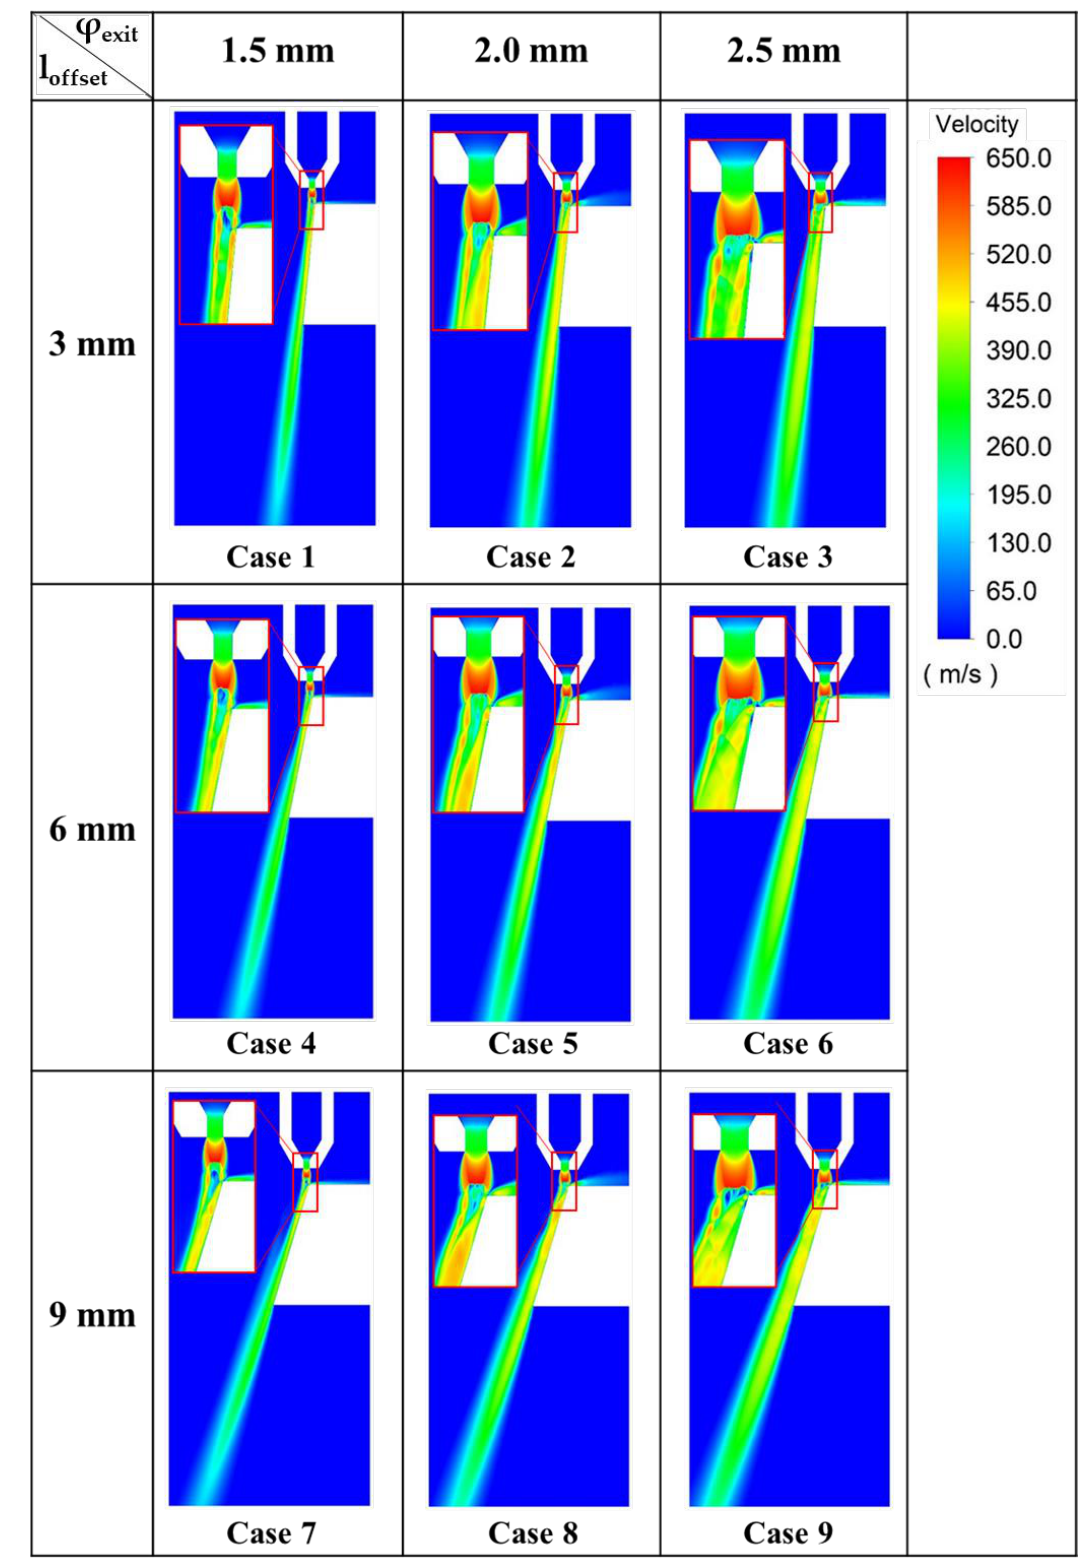
Figure 10. Numerical simulation results for the velocity field along the symmetry plane.